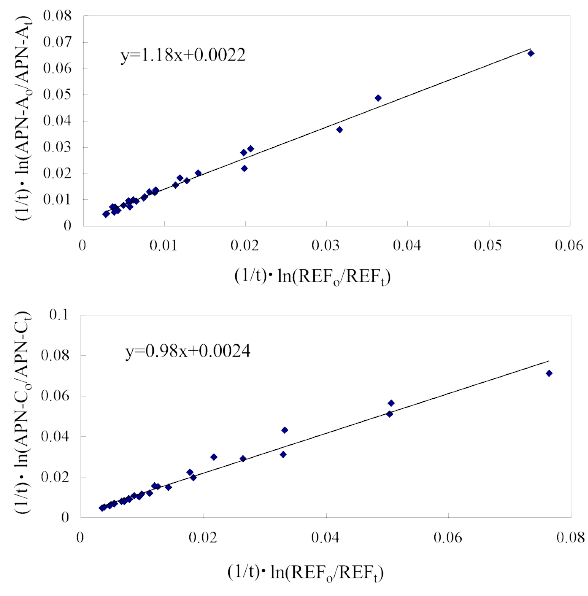
Fig.6. OH rate constantdata for the two α-pinene hydroxy nitrate isomers,APN-A(top),APN-C (bottom). Fig. 6. OH rate constant data for the two α -pinene hydroxy nitrate isomers, APN-A (top), APN-C